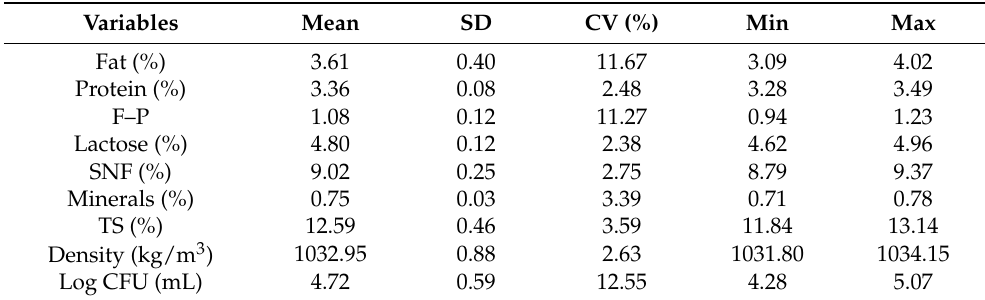
Table 1. Descriptive statistics of the raw milk composition variables obtained in the evaluated dual-purpose systems.